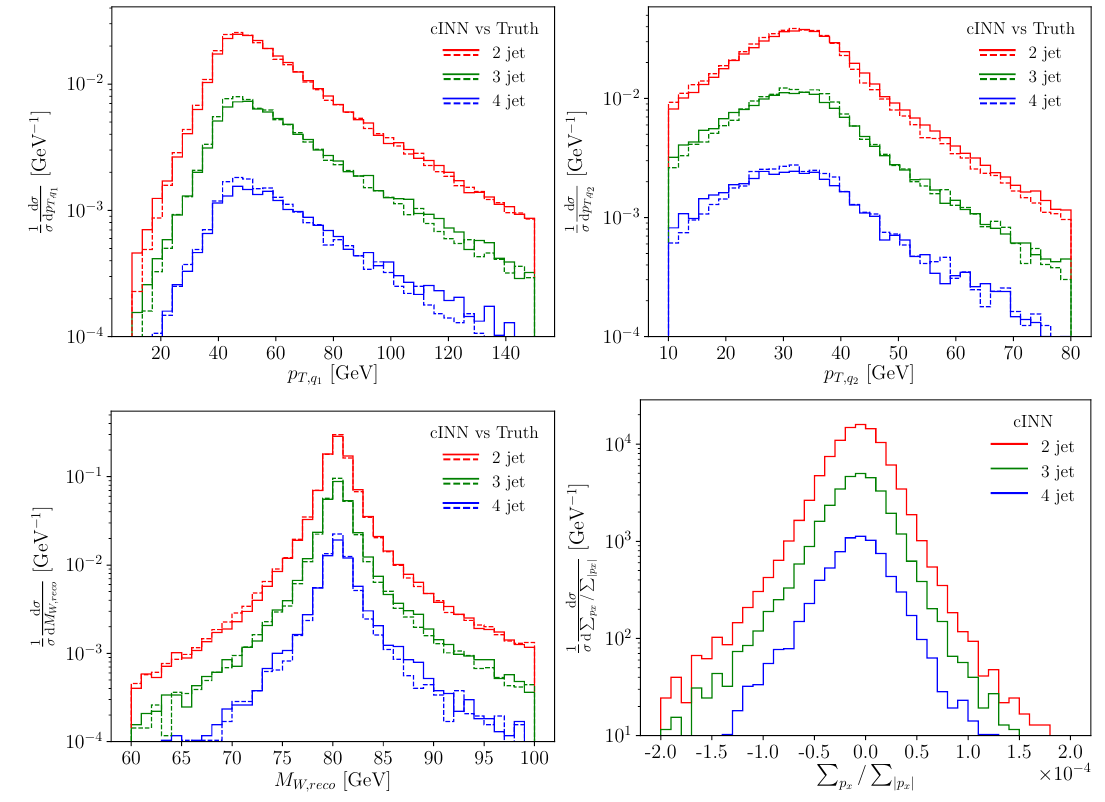
Figure 10: cINNed example distributions. Training and testing events include two to four events, combining the samples from Fig. 6 and Fig. 8 in one network. The parton-level events are stacked by number of jets at detector